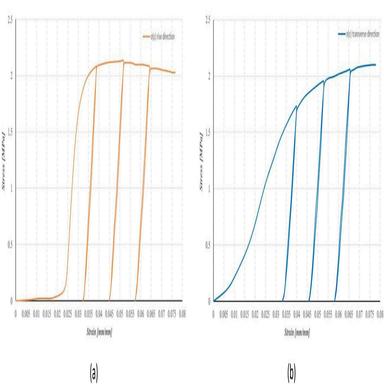
Experimental stress-strain curve in the (a) rise and (b) transverse directions).